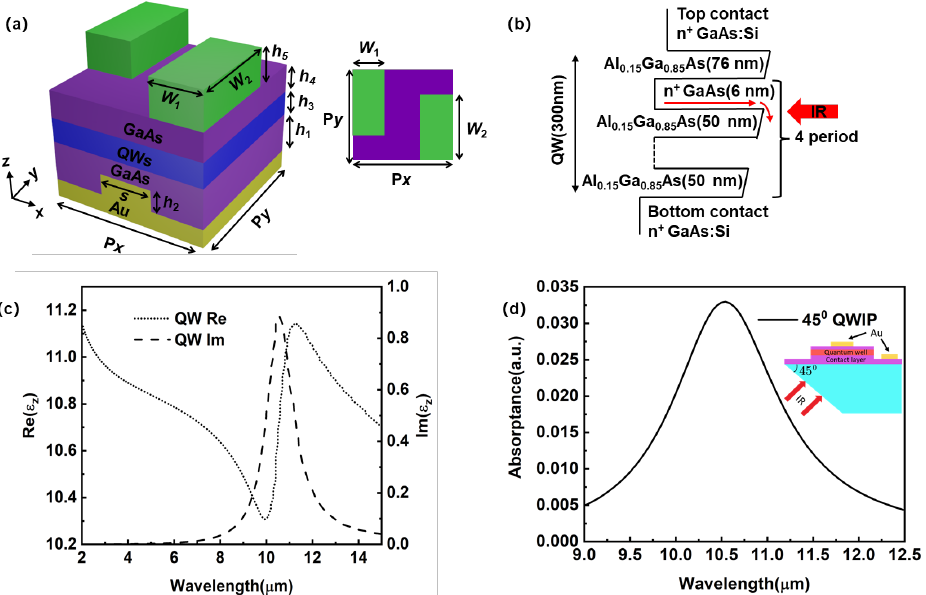
Figure 1. ( a ) Schematic diagram of the 3D structure of the dielectric-metal-hybrid chiral metamirror integrated quantum well infrared photodetector (QWIP). The inset figure shows the schematic dia- gram of a Z -groove unit cell in the x - y view. Structural parameters: P x = 3.9 μm, P y =3.9 μm, W 1 = 1.25 μm, W 2 = 2.5 μm. The thicknesses of the bottom contact layer, the grating, the QWs, the un- carved part of top contact layer, and the 2D chiral structure are h 1 = 560 nm, h 2 = 360 nm, h 3 = 300 nm, h 4 = 520 nm, h 5 = 4.35 μm, and s = 1.326 μm. The chiral metamateria l is drawn in green. ( b ) The active region with a total thickness ( h 3 ) of 300 nm contains four AlGaAs (50 nm)/GaAs (6 nm) QW stacks. ( c ) Real and imaginary parts of 𝜀 z . The dielectric constant of the effective medium of the QWs is diag ( 𝜀 x , 𝜀 y , 𝜀 z ). ( d ) Absorption efficiency of a standard 45° edge facet coupled device. 3. Results and Discussion Figure 2a,b show the absorptance and reflectance spectra of a dielectric-metal-hybrid chiral metamirror integrated QWIP under LCP and RCP illumination. RCP light induces a prominent resonance at the wavelength of 10.55 μm, where the absorption efficiency of the device reaches 54%. The prominent resonance at the wavelength of 10.55 μm corre- sponds to a surface plasmon polariton (SPP) wave at the interface between the metal grat- ing and the bottom GaAs contact layer (Figure 2c). The metal grating provides an extra tangential wave vector equal to the propagation constant of the SPP wave. Accordingly, the normally incident light with an electric component along the x -direction could effec- tively excite the SPP wave. When the SPP mode is excited, an intensified local field is built up and both the absorptance of the QWs and that of the metal are increased, resulting in a reflectance as low as 5%. In comparison, LCP light does not effectively excite the SPP wave, and it is largely reflected by the dielectric-metal-hybrid chiral metamirror inte- grated QWIP. The discrimination of the handedness of the light is due to the interference between the principle-polarization radiation and the cross-polarization radiation of the chiral structure during multiple reflections. In brief, if we consider the dielectric-metal chiral metamirror as a film for interference, the SPP waves excited by LCP light during the multiple reflections in this film destructively interfere with each other, while, in con- trast, the SPP waves excited by RCP light during the multiple reflections constructively interfere with each other. The multiple-reflection interference is analyzed in detail later. Further, the circular polarization discrimination is magnified by the double polarization selection provided by the chiral metamirror and the QWs [19,40,45]. Since the QWs only